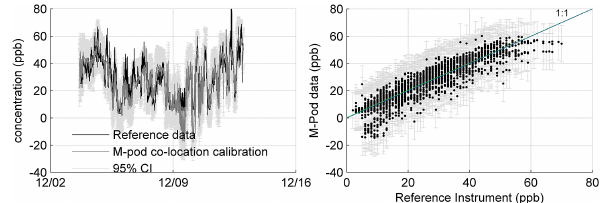
Figure 3. NO 2 data from M-Pod 23 from the December collocation.